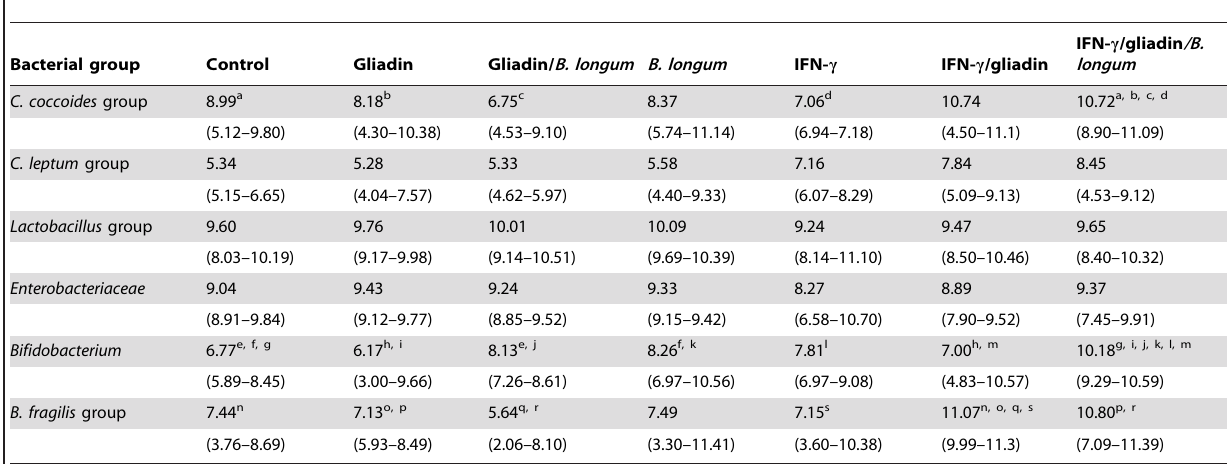
Figure 4. Phenotyping of lymphocyte populations in peripheral blood of rats after different treatments. The results are expressed as mean 6 standard deviation (n=6). *Indicates statistically significant ( P , 0.05) differences relative to the controls; bars indicate significant differences between the specific pair comparisons as determined by applying the Student t test. Table 3. Microbiota composition of colon content determined by real time PCR and expressed as log copy number of 16S rDNA gene per gram of faeces.